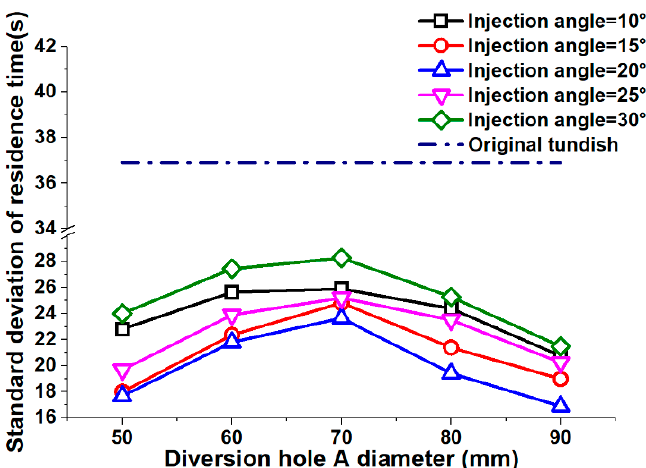
Figure 6. Residence time standard deviation distribution.